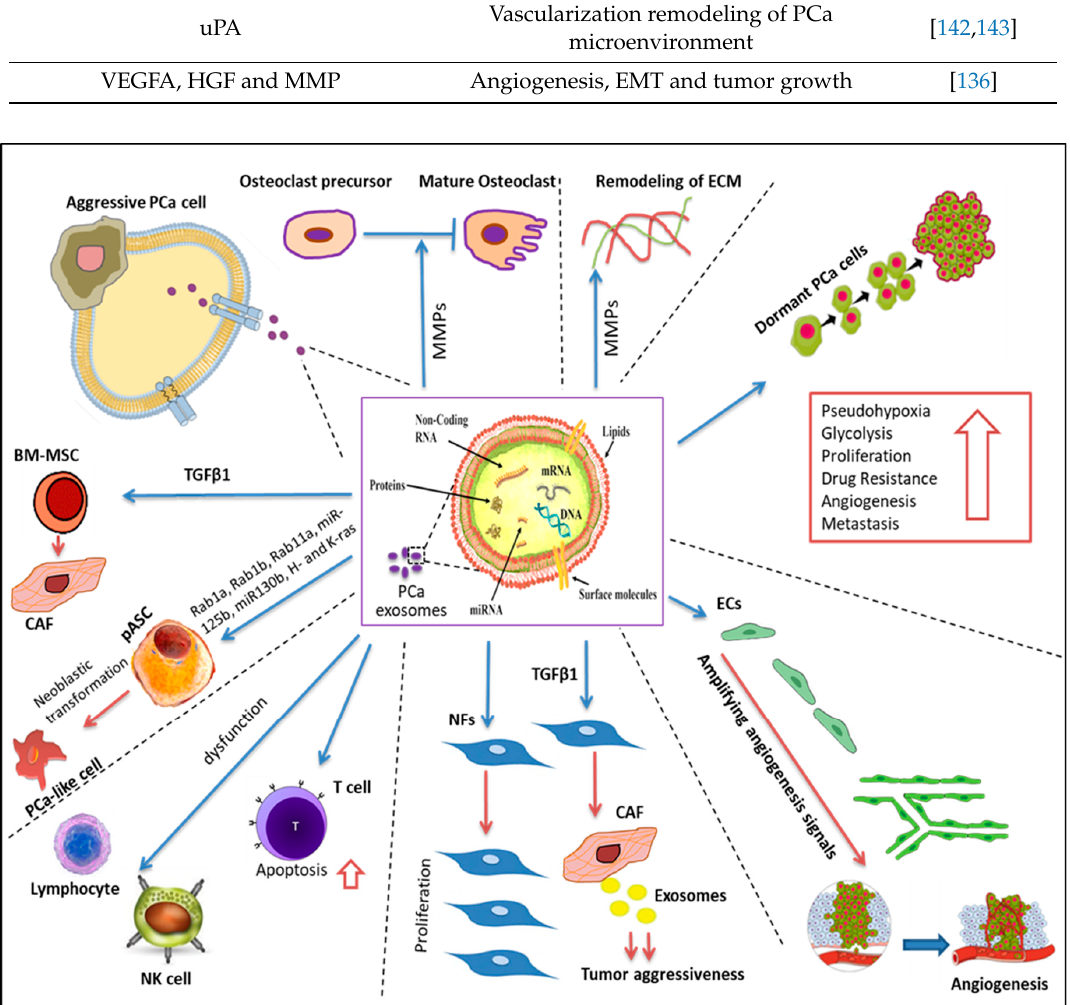
Figure 2. The potential roles of prostate cancer (PCa)-associated exosomes in modulating different cells in the TME. Exosomes-associated cargo shuttles bioactive molecules to and from PCa cells to activate stromal cells in the TME for gaining new genetic traits and promoting PCa progression and metastasis. Fibroblast cells (FB), cancer associate fibroblast (CAF), endothelial cells (ECs), patient adipose derived stem cells (pASC), T cell, natural killer cells (NK), lymphocytes, bone marrow-mesenchymal stem cells (BM-MSC), osteoclast cells, extracellular matrix (ECM). Part of this figure was prepared by the aid of Mind the GRAPH program available on https: // mindthegraph.com /